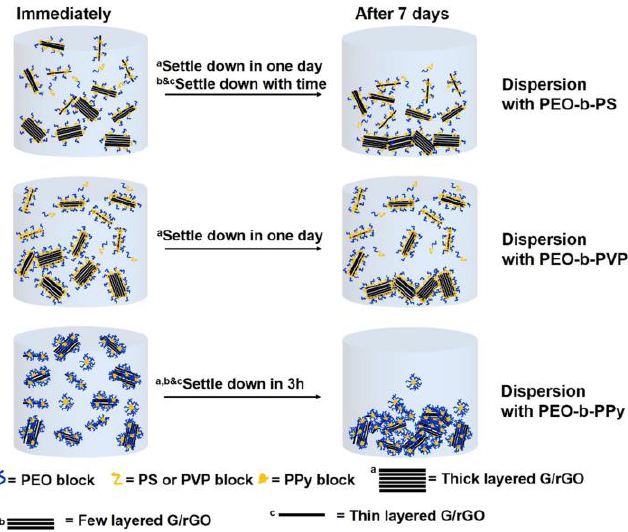
Figure 7. Illustration of the destabilization of graphene dispersions stabilized with PEO-b-PS, PEO-b- PVP, and PEO-b-PPy polymers in ethanol [109]. (Reproduced from [109] with permission; Copyright 2017 Elsevier).